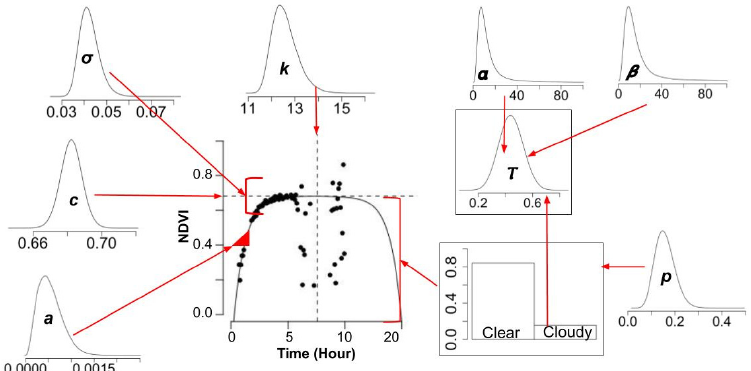
Figure 2. Depiction of the model using an example from one day (2017-08-19) at Russell Sage. The central plot indicates the normalized difference vegetation index (NDVI) observations in black points. The solid curve line represents the median model fit. The solid horizontal and vertical lines indicate the mean values for the parameters c and k , respectively. Except for the distributions surrounded by a box, the parameter distributions indicate the posterior distributions over all of the samples. The boxes around the transmissivity ( T ) and isCloudy (clear vs. cloudy) indicate that these are the distributions of the values for the observations of one sample of the one day using the posterior means of the parameters p, α , and β .